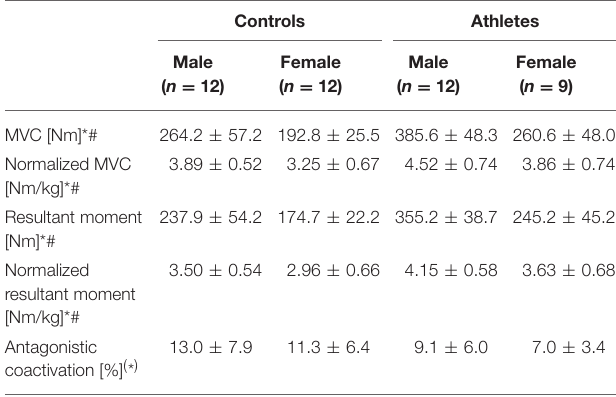
TABLE 1 | Antrhopometric data of the adolescent controls and volleyball athletes. Controls